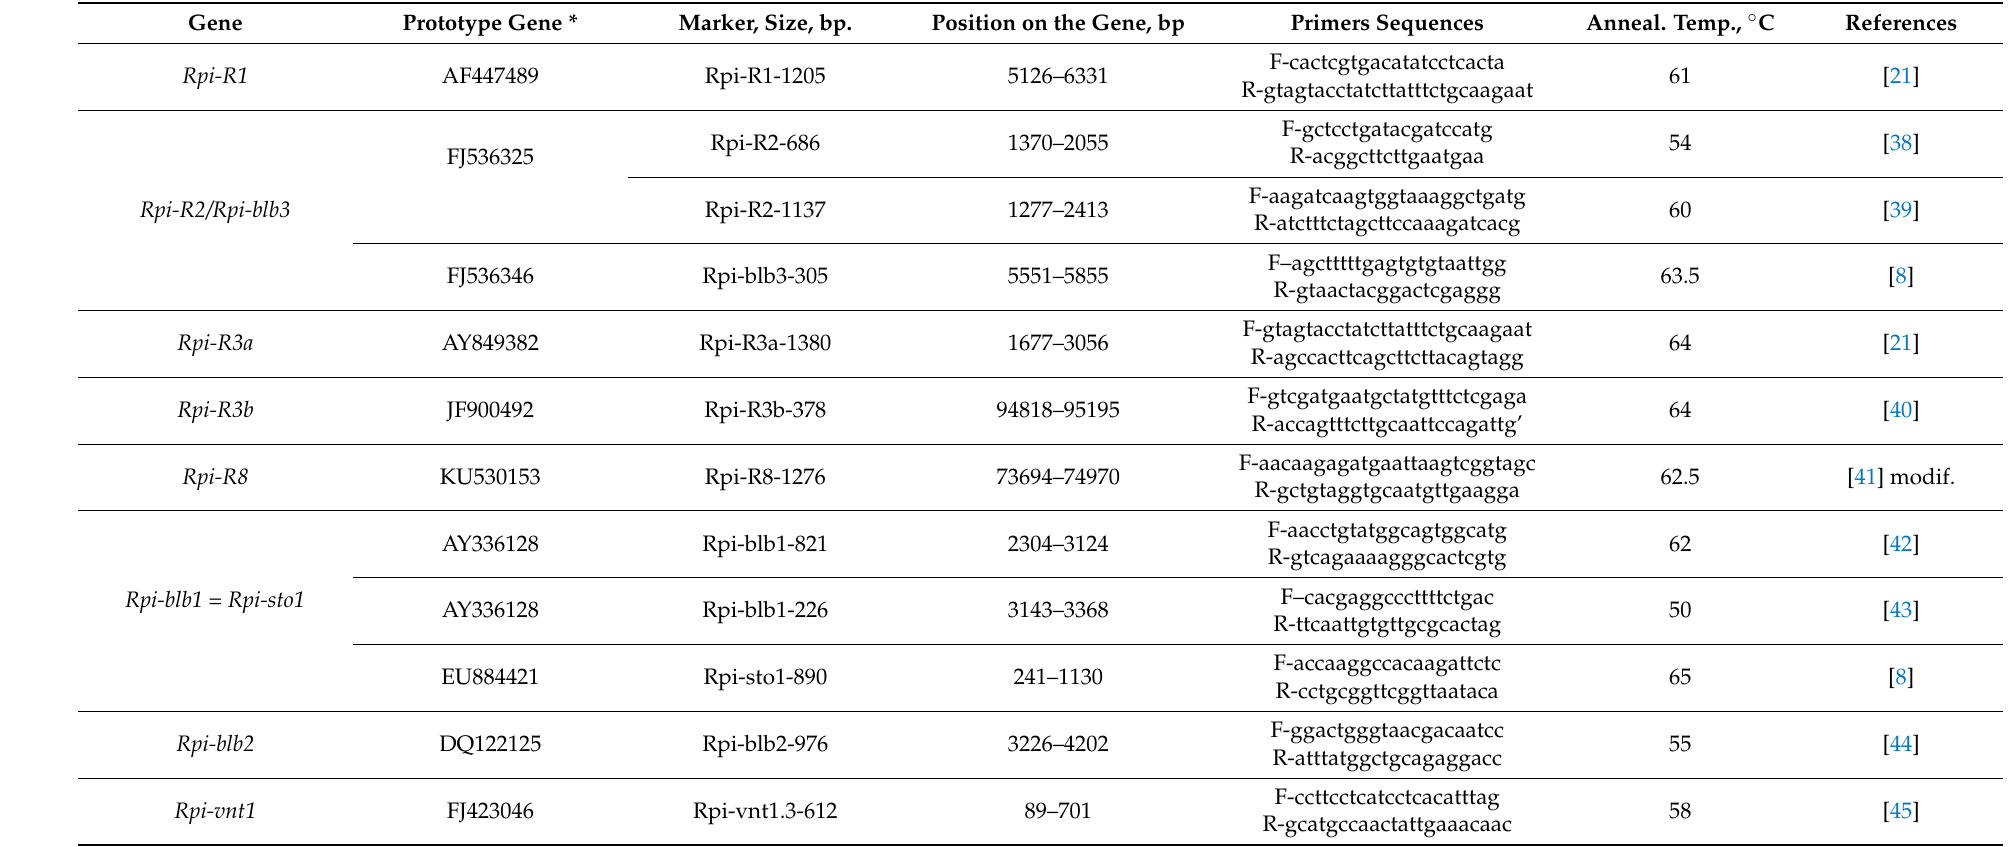
Table 3. SCAR markers of Solanum Rpi genes (see also Figure